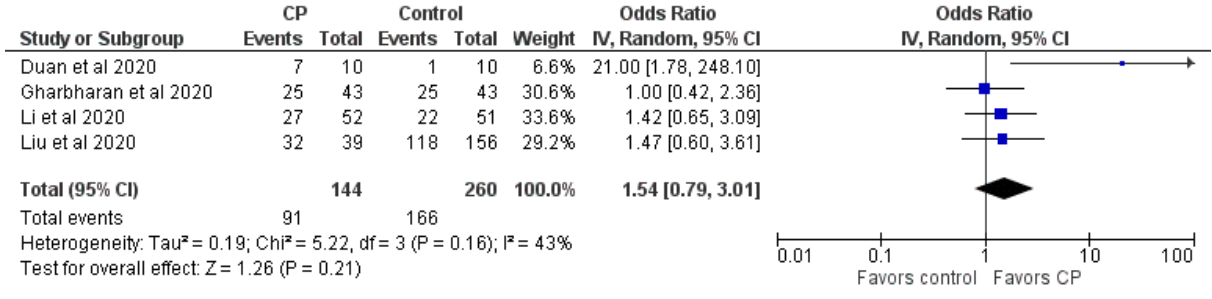
Figure 4. Efficacy of CP treatment on clinical improvement in COVID-19 patients. Data from 4 controlled clinical trials were pooled using an inverse variance method and analyzed using a random-effects model. Odds ratios and 95% CIs were used as statistical measures for clinical improvement as a dichotomous outcome. CP: convalescent